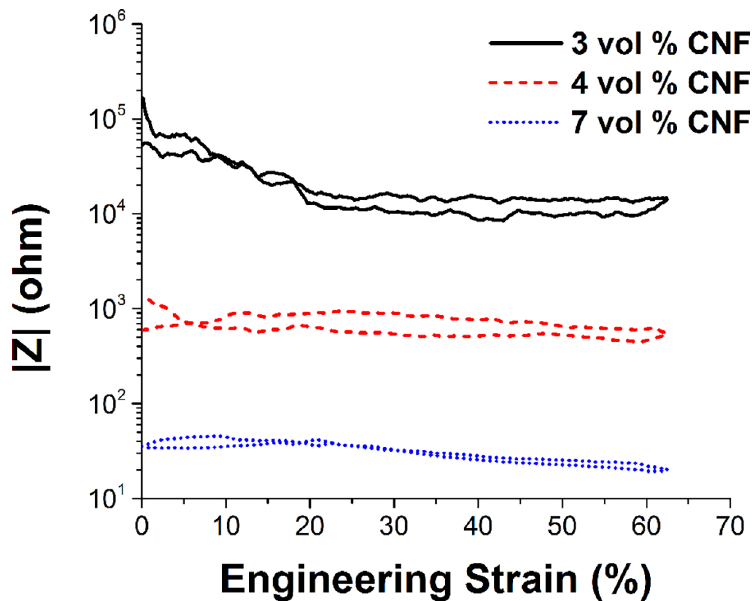
Fig 4. Single frequency (10Hz) electrical impedance performance over a single strain cycle (increasing/decreasing) for electrode filler loadings of 3, 4 and 7 vol % carbon nanofiber in